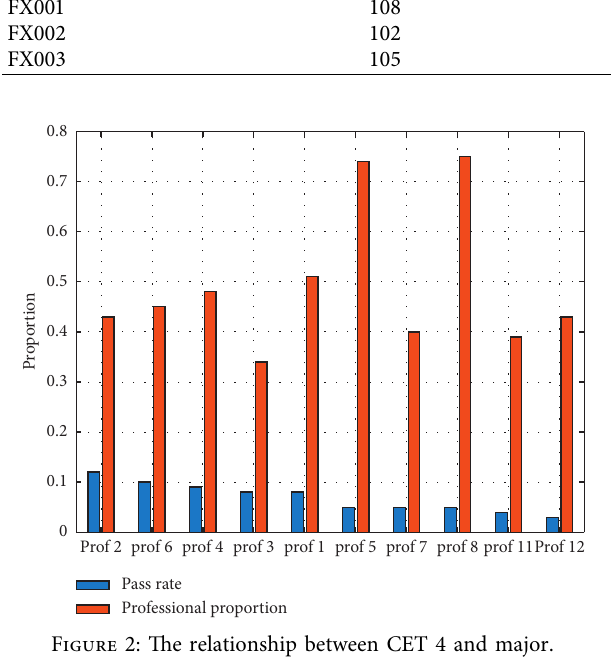
Figure 2: The relationship between CET 4 and major.